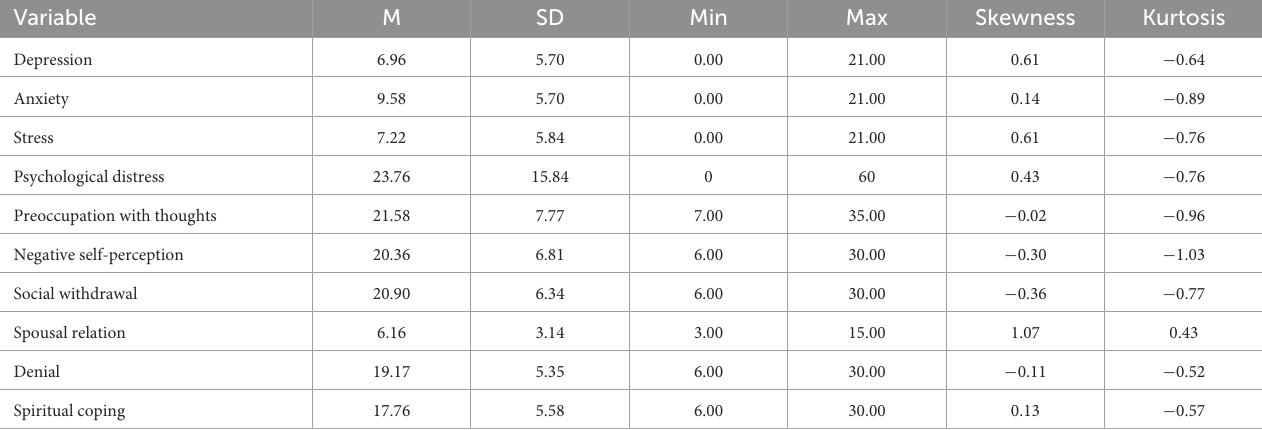
TABLE 2 Descriptive statistics for the main variables ( N = 193).